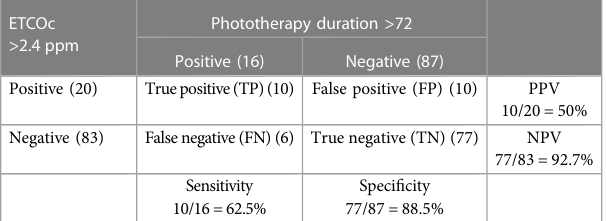
TABLE 4 Sensitivity, speci fi city, PPV, and NPV for ETCOc greater than 2.4 ppm. ETCOc >2.4 ppm